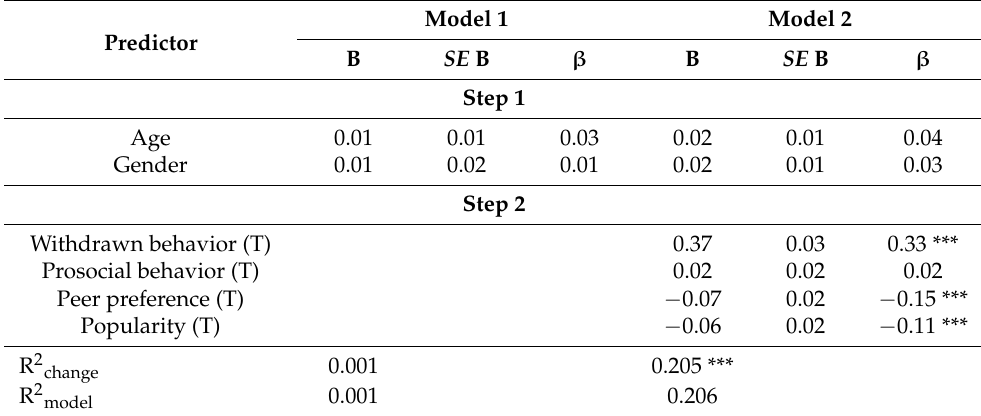
Table 3. Hierarchical Regression Model of Social Characteristics Predicting Loneliness Teacher